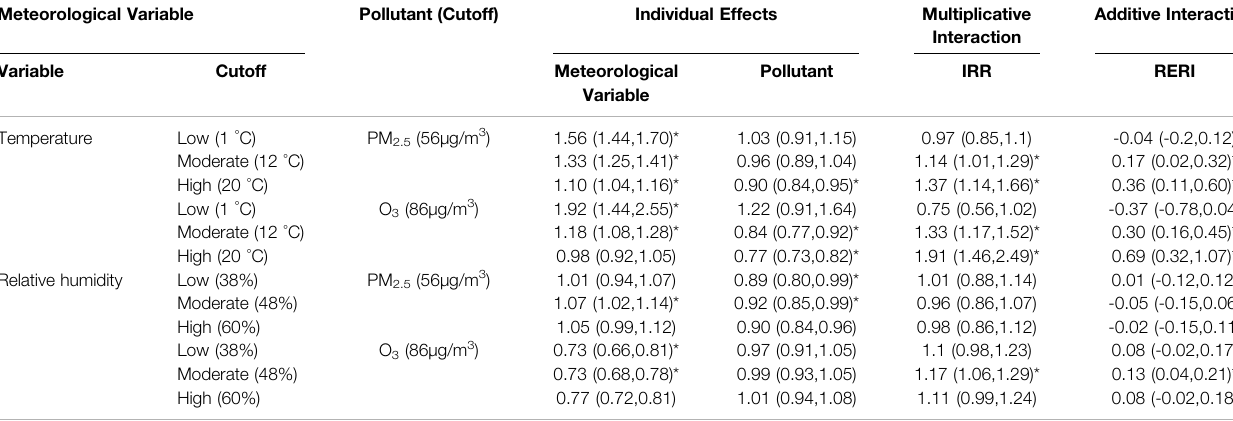
TABLE 3 | Additive and multiplicative interactive analysis between meteorological variables and air pollutants on mumps. Meteorological